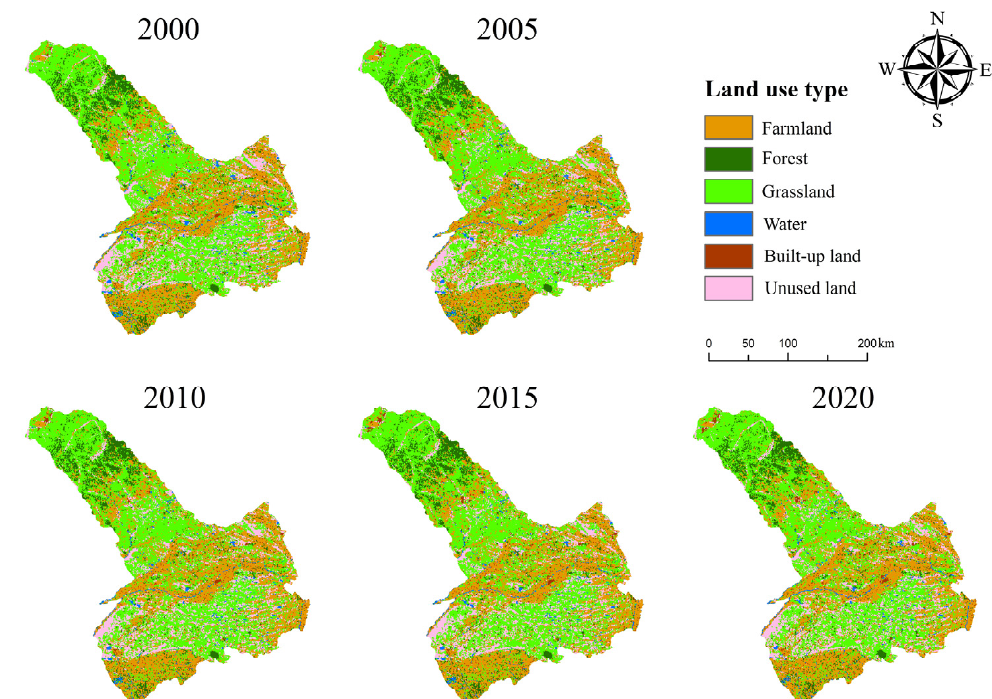
Figure 3. Spatial distribution of LULC from 2000 to 2020. Table 2. LULC change in the study area during different periods (km 2 ).